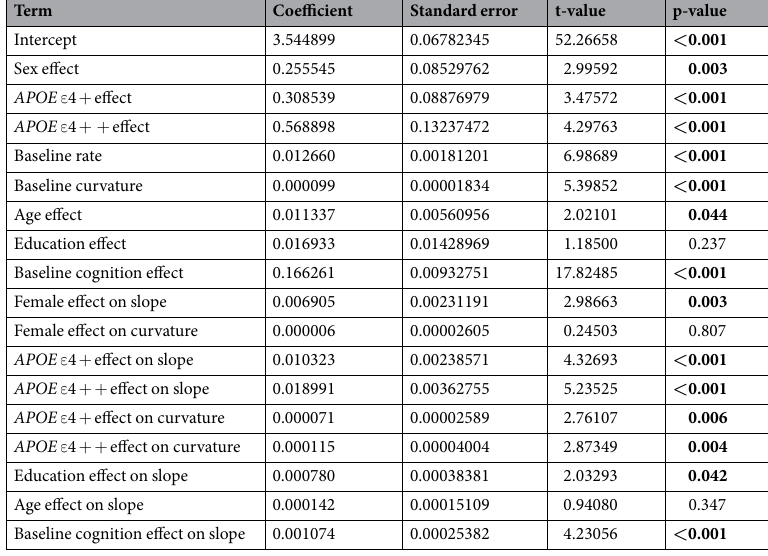
Table 2. Effect of Sex and APOE ε 4 on longitudinal change in ADAS-Cog11 of MCI subjects. Baseline cognition indicates ADAS-Cog 11. Bold p -values are statistically significant. Abbreviations: MCI (mild cognitive impairment), ADAS-Cog11 (Alzheimer’s disease assessment scale- cognitive subscale), and APOE ε 4 (apolipoprotein ε 4 allele). In this model, the follow-up time (month) was centered with the median follow-up time (36 months) and covariates were centered i.e. a 75 years old APOE ε 4- male with 16 years of education and an ADAS-Cog11 of 11. Table depicts that the effect of sex on ADAS-Cog11 change was significant with females declining faster than males. Education and baseline cognition also had significant effects. The intercept is a term to get the correct estimate of the outcome when time = 0. The baseline rate is the reference population rate of change in the outcome starting at time zero, and the baseline curvature is the “acceleration” of that rate of change at time zero. The upper half of the table shows the effect of specific variables on ADAS-Cog11 and the bottom half shows their effects on ADAS-Cog11 slope and